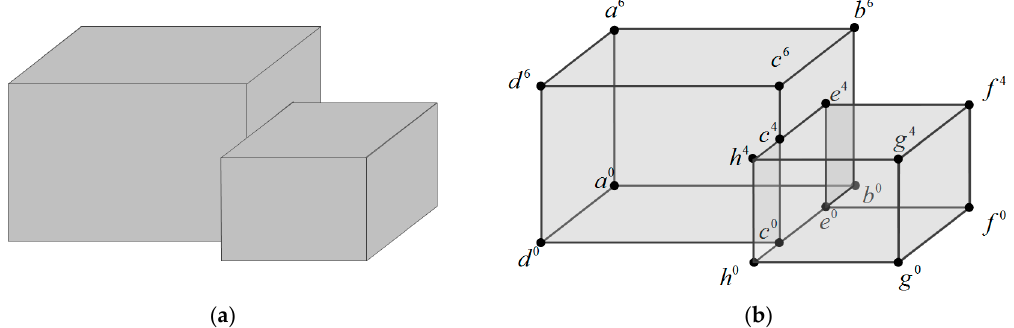
Figure 14. Geometric model ( a ) and topological features ( b ) that were constructed by merging primitives and removing redundancies in Figure 12b.